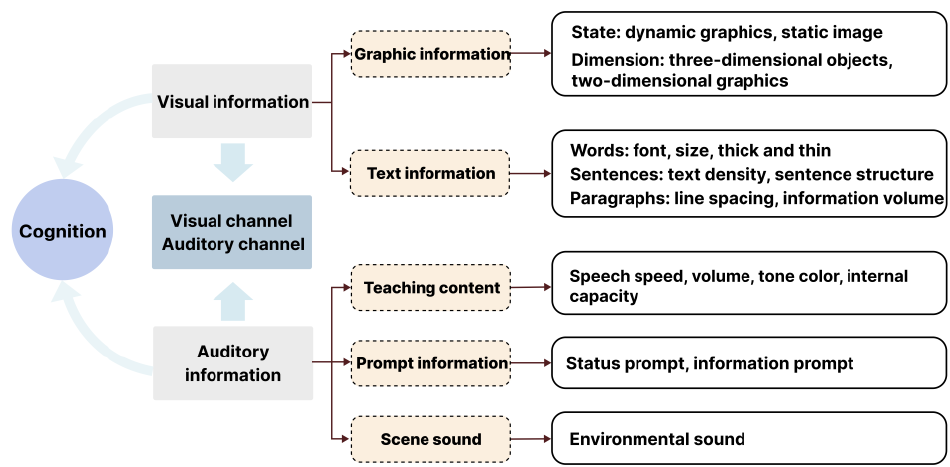
Figure 3. Summary of instructional information affecting users’ cognitive load intensity in virtual reality online education.